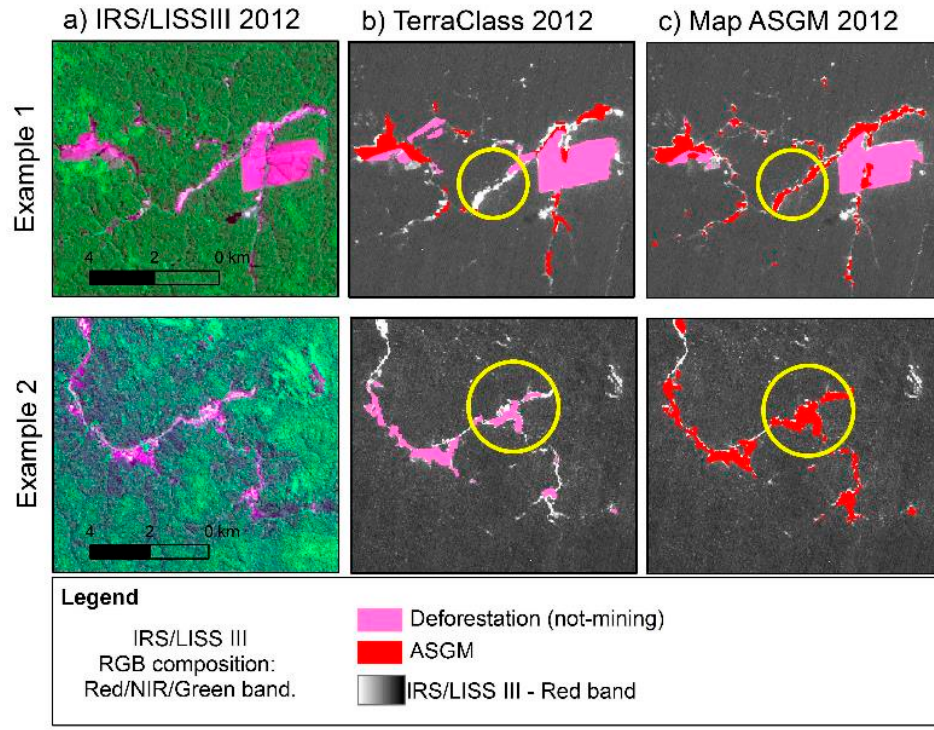
Figure 8. ( a ) The IRS/LISSIII was used as a background image to support ASGM identification in 2012. Examples of performance of TerraClass-2012 ( b ) and updated MapASGM-2012 ( c ), are given in two image subsets to illustrate the omission (Example 1) and misclassification errors (Example 2) observed for TerraClass-2012 in comparison to updated MapASGM-2012 (yellow circles).